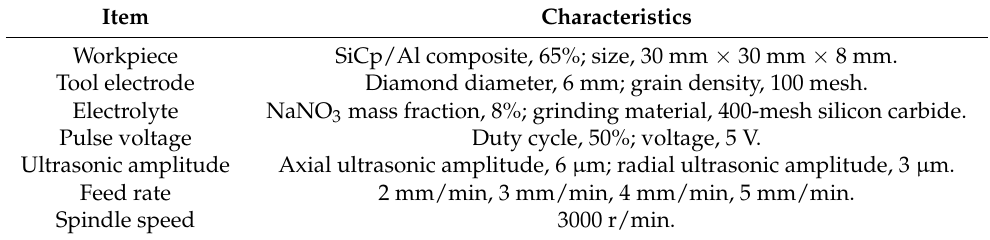
Table 3. Material Table 3. Material parameters.